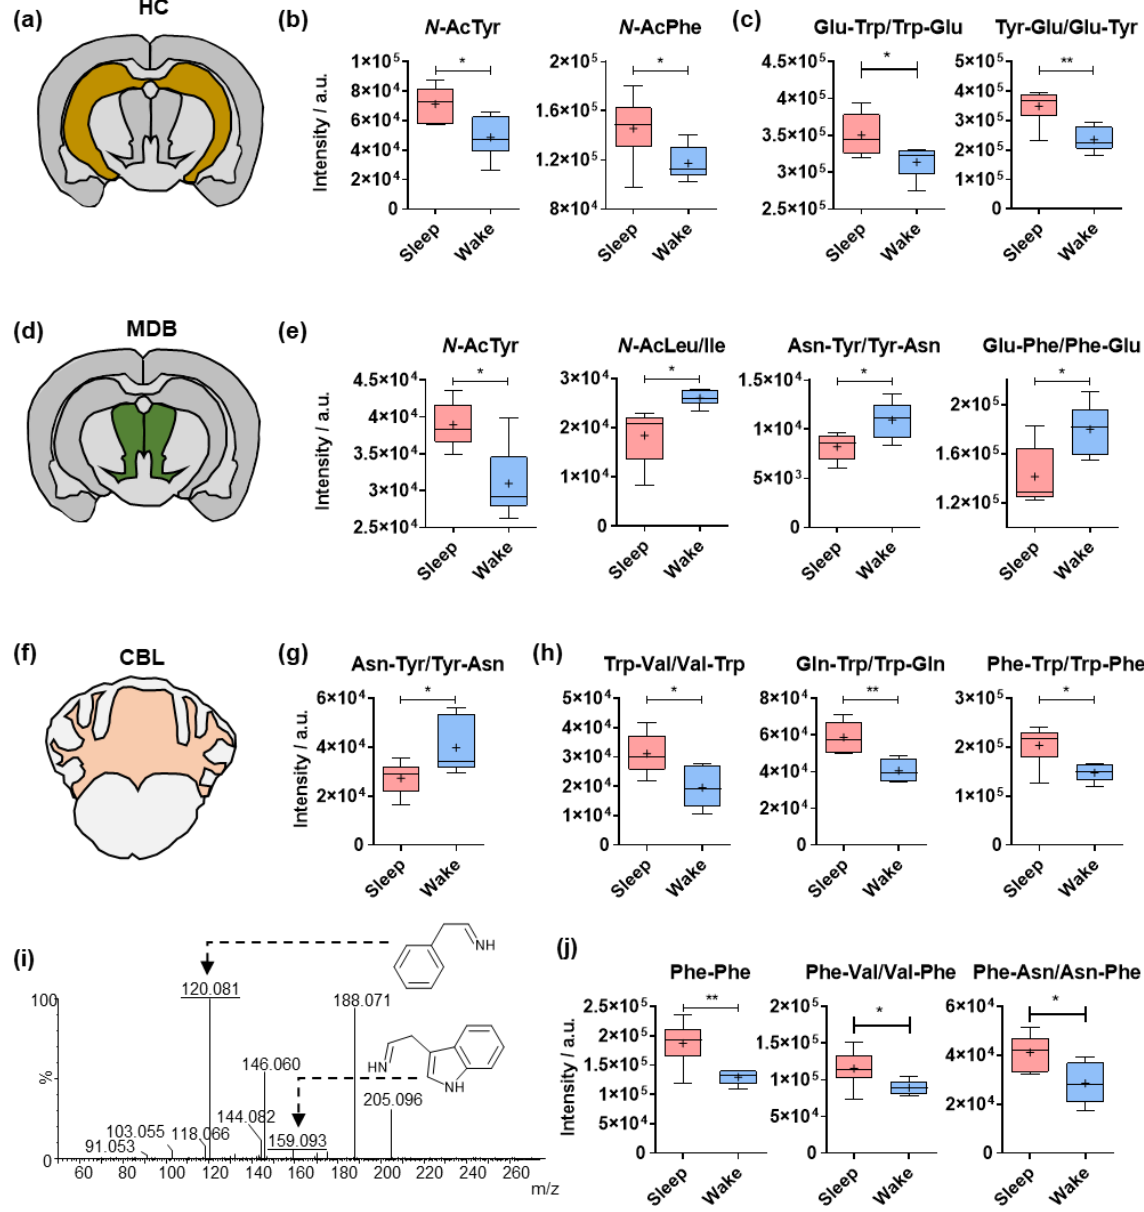
Figure 3. Sleep-specific alterations in the brain regional levels of amino acid analogues. ( a ) Illustration of the hippocampus (HC) in a coronal mouse tissue section. ( b ) Mass spectrometric intensities of N -acetyl-tyrosine and N -acetyl-phenylalanine in the hippocampus (N = 6). ( c ) Mass spectrometric intensities of representative tryptophan (Trp)- and tyrosine (Tyr)-containing dipeptides in the hip- pocampus (N = 6). ( d ) Illustration of the midbrain (MDB) in a coronal mouse tissue section. ( e ) Mass spectrometric intensities of representative amino acid analogues in the midbrain (N = 6). ( f ) Illustra- tion of the cerebellum (CBL) in a coronal mouse tissue section. ( g ) Mass spectrometric intensities of representative tyrosine (Tyr)-containing dipeptides in the cerebellum (N = 6). ( h ) Mass spectromet- ric intensities of representative tryptophan (Trp)-containing dipeptides in the cerebellum (N = 6). ( i ) Structure validation of phenylalanine (Phe)- and tryptophan (Trp)-containing dipeptide by tandem spectra collected from pooled brain sample. The immonium product ions from the protonated amino acids are underlined and structurally illustrated. ( j ) Mass spectrometric intensities of repre- sentative phenylalanine (Phe)-containing dipeptides in the cerebellum (N = 6). Error bars: min and